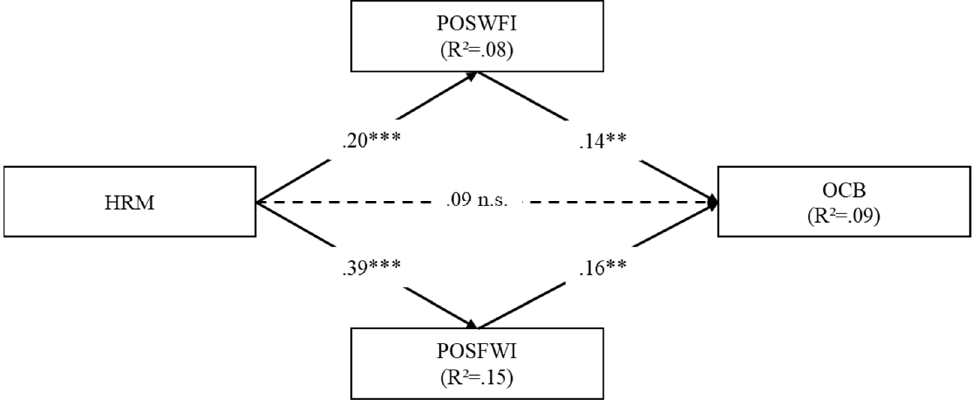
Figure 2. The mediation model. HRM = Human Resource Management. POSWIF = Positive work- to-family spillover. POSFWI = Positive family-to-work spillover. OCB = Organizational Citizenship Behaviours. ** p < 0.01. *** p < 0.001. The effects of control variables on the mediators and outcome are estimated but not shown for figure clarity.